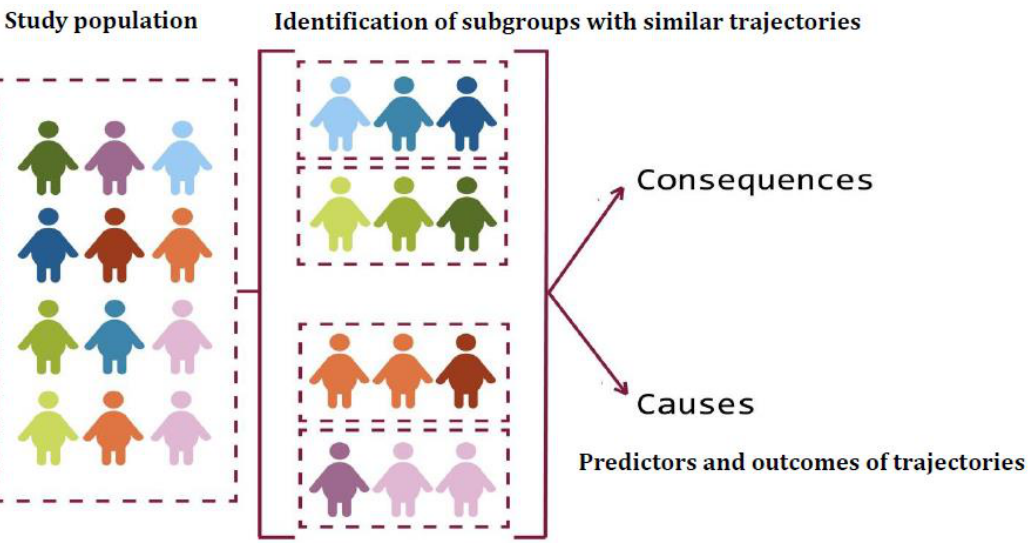
Figure 1. The fundamental assumptions of GBTM .